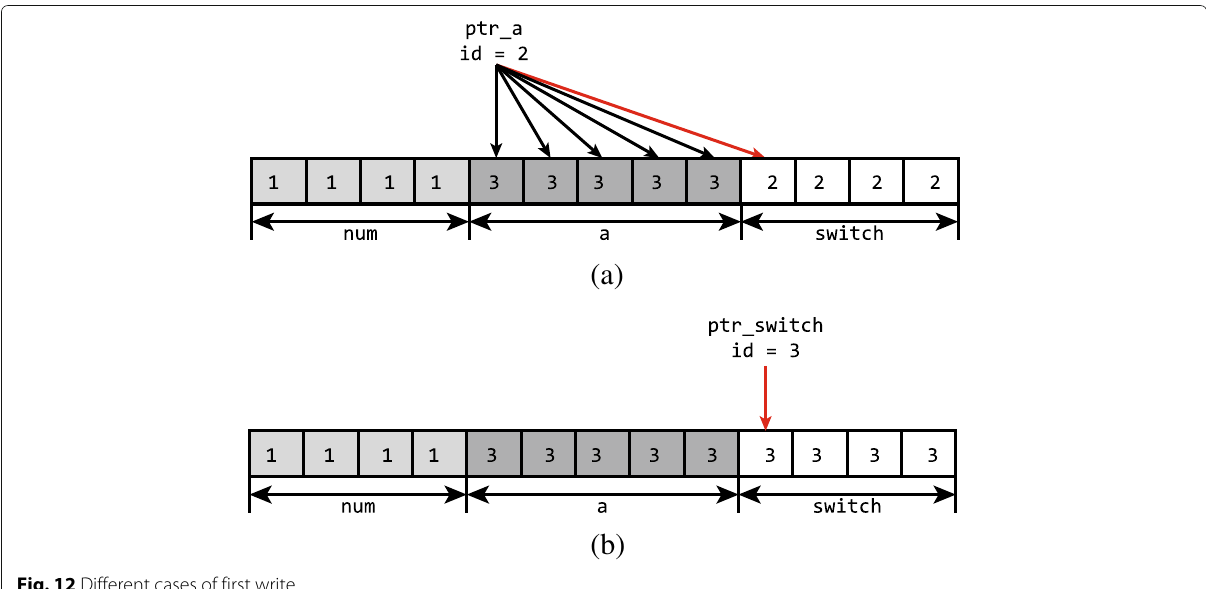
Fig. 12 Different cases of first write